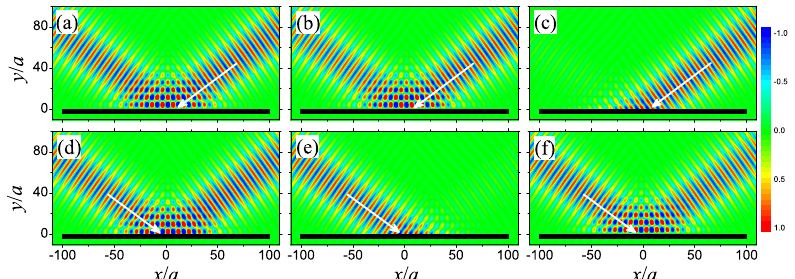
Figure 6. The electric field patterns illustrating the nonreciprocal perfect absorption for a Gaussian beam striking the composite MM slab of type II from the right hand side with θ inc = 55 ◦ ( a – c ) and from the left hand side with θ inc = − 55 ◦ ( d – f ). The lossless MM slab with damping factors α = 0 ( a , d ), the lossy MM slab with damping factor α = 5 × 10 − 3 ( b , e ), and the lossy MM slab with damping factor α = 5 × 10 − 3 under reversed magnetization ( c , f ) are considered. The radius of dielectric core is r c = 0.88 mm, the BMF is H 0 = 600 Oe, the working frequency is f = 4 GHz, and the other parameters are the same as those in Figure